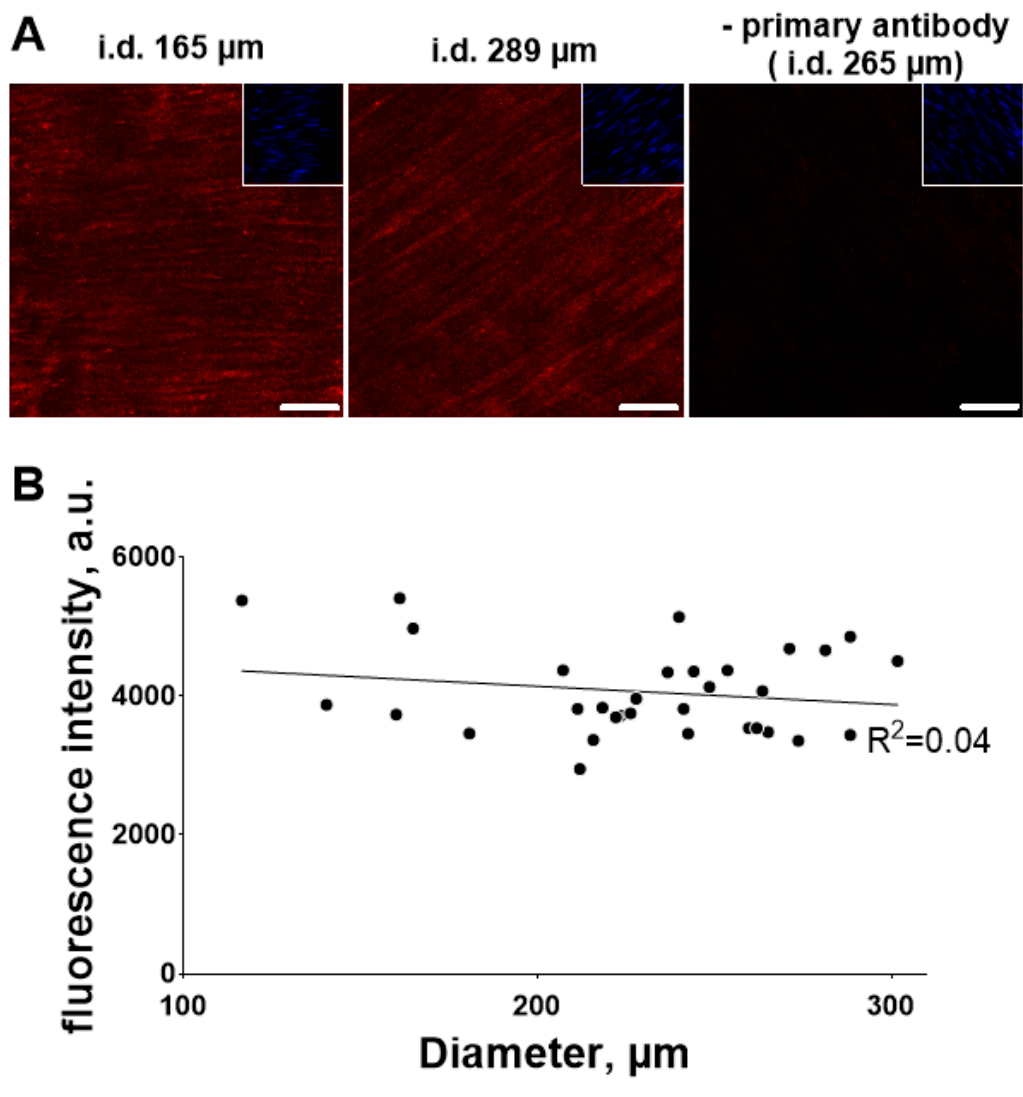
Figure 7. No difference in total Src expression between mesenteric arteries with different diameters. ( A ) shows representative images of arteries with different diameters as indicated (bars indicates 20 µm). Total Src related fluorescence intensity was measured in smooth muscle layer in the vascular wall, as indicated by SYTO-16 based nuclei staining (inserts in images). No difference in fluorescence intensity in arteries with different inner diameter was seen ( B ). R 2 on the graph indicates linear regression quantifies goodness of fit. n = 32.